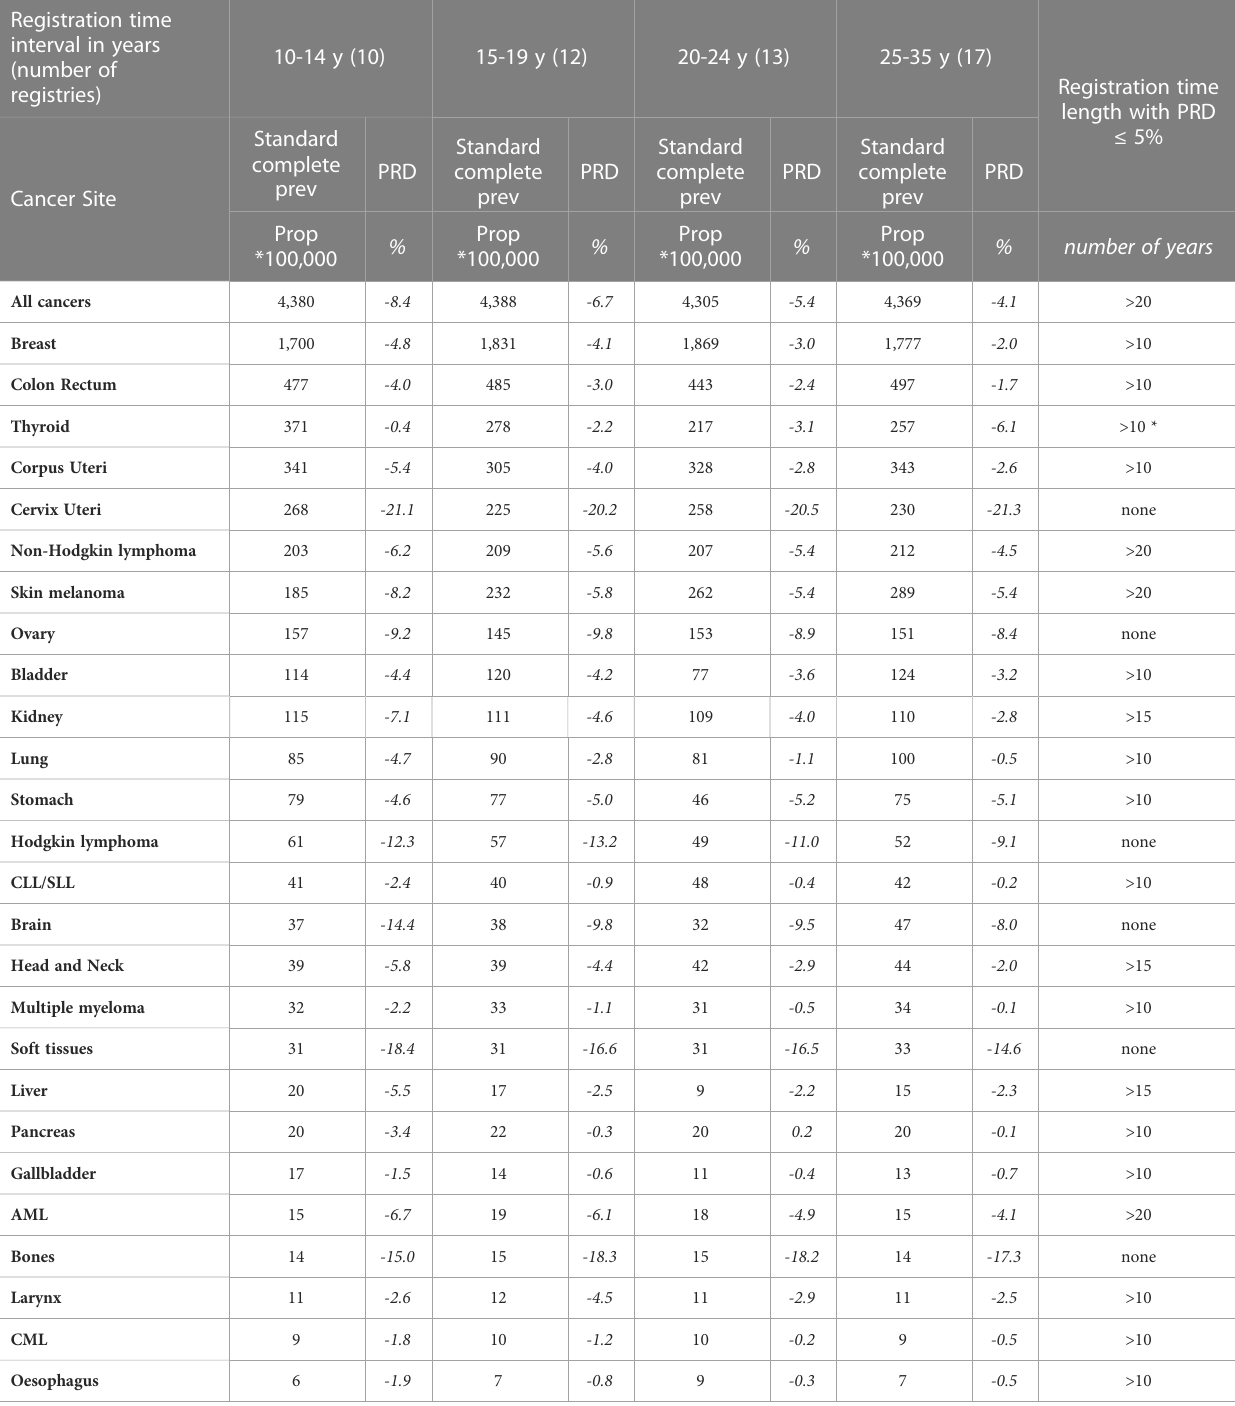
TABLE 3B Comparison between empirical and standard model-based complete prevalence at 1/1/2013 by cancer site for the 62 European registries included in the study grouped by registration time length (from 10-14 years to 25-35 years),